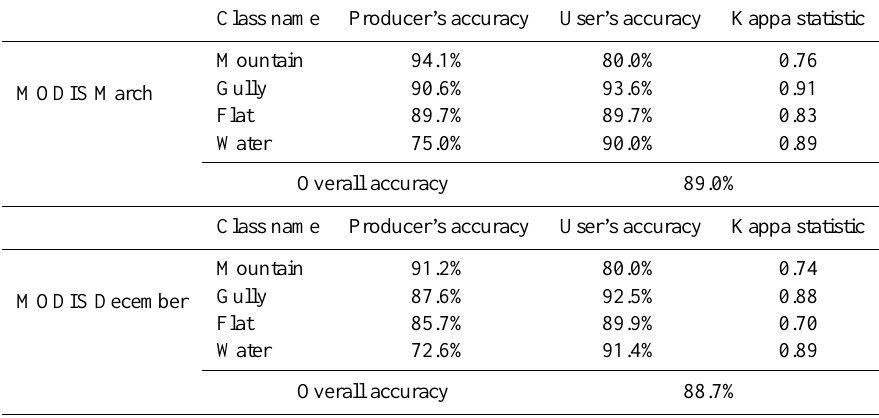
Table 6. Validation of MODIS classification: accuracy statistics report indicating the outcome of the accuracy assessment of the used supervised classifier.